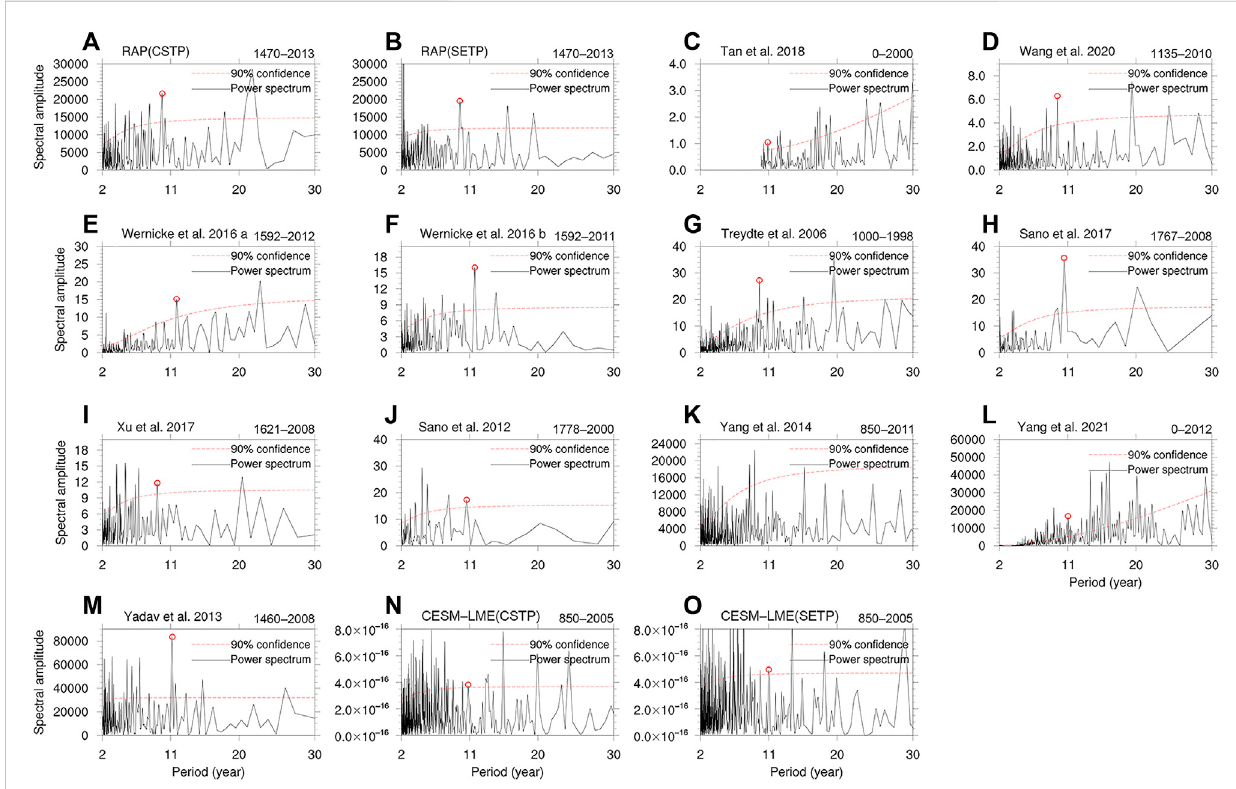
FIGURE 3 Power spectrum analysis of reconstructions (A – M) and simulations (N – O) . (A) Result of RAP over central – southern TP. (B) same as (A) , but over southeastern TP (C – M) Results from different proxy records across the TP listed in Table 1. (N) Results from the ensemble mean of four TSI experiments over central – southern TP. (O) same as (N) , but over southeastern TP. Red dashed lines represent the 90% signi fi cance level; red circles mark the signi fi cant 11-year cycle.